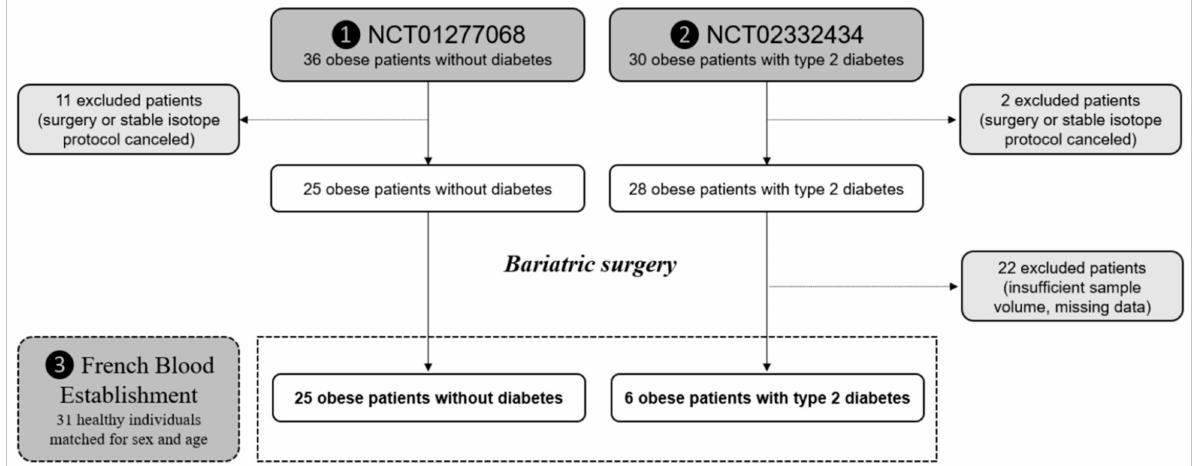
Figure 5. Participant